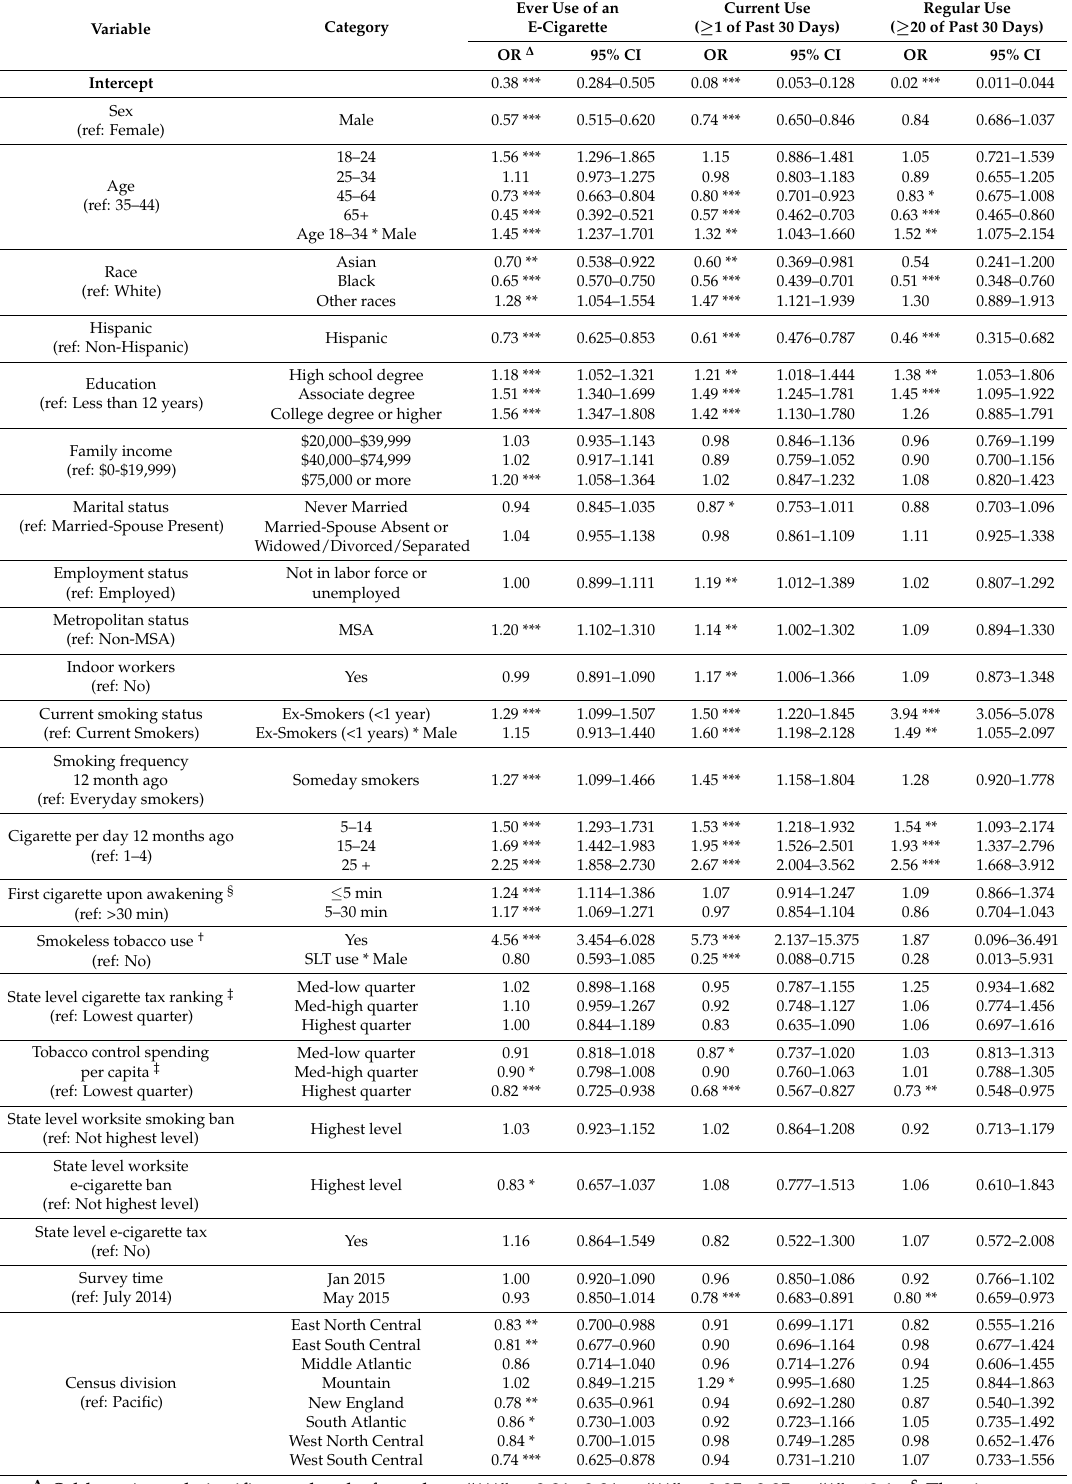
Table 3. Odds ratios for, ever, current and regular measures of e-cigarette use of smokers 12 months ago, CPS-TUS,